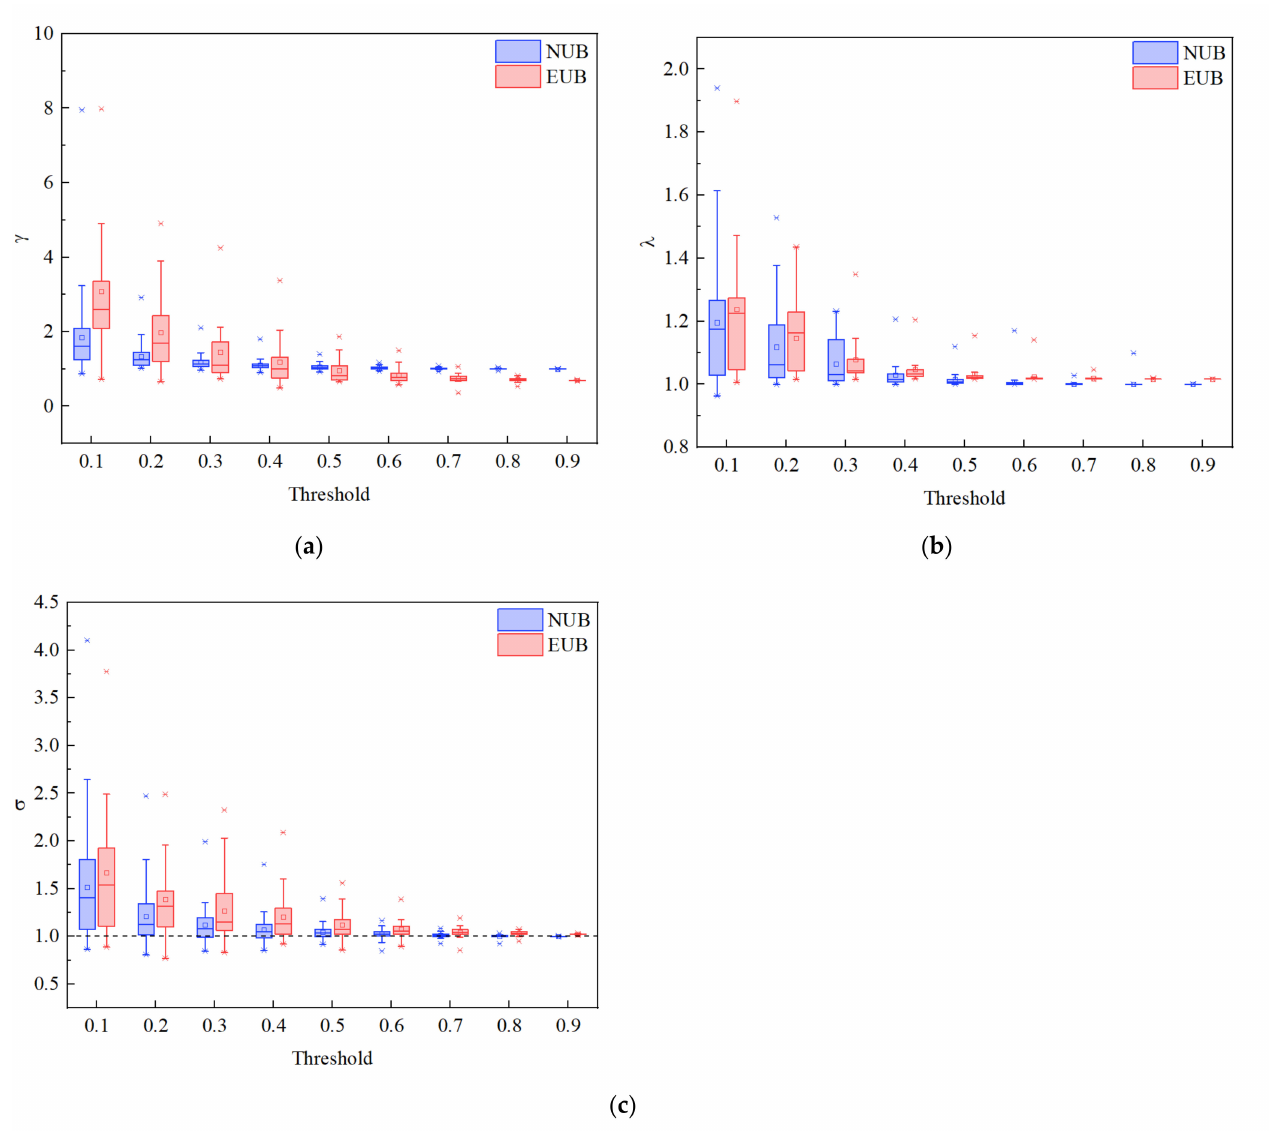
Figure 6. Comparison of the NUB brain network to the EUB brain network: small-worldness. Brain network data were based on the functional networks generated from the oxy-Hb measurements over continuous threshold values ((T ∈ (0.1:0.1:0.9)). ( a ) γ . ( b ) λ . ( c ) σ